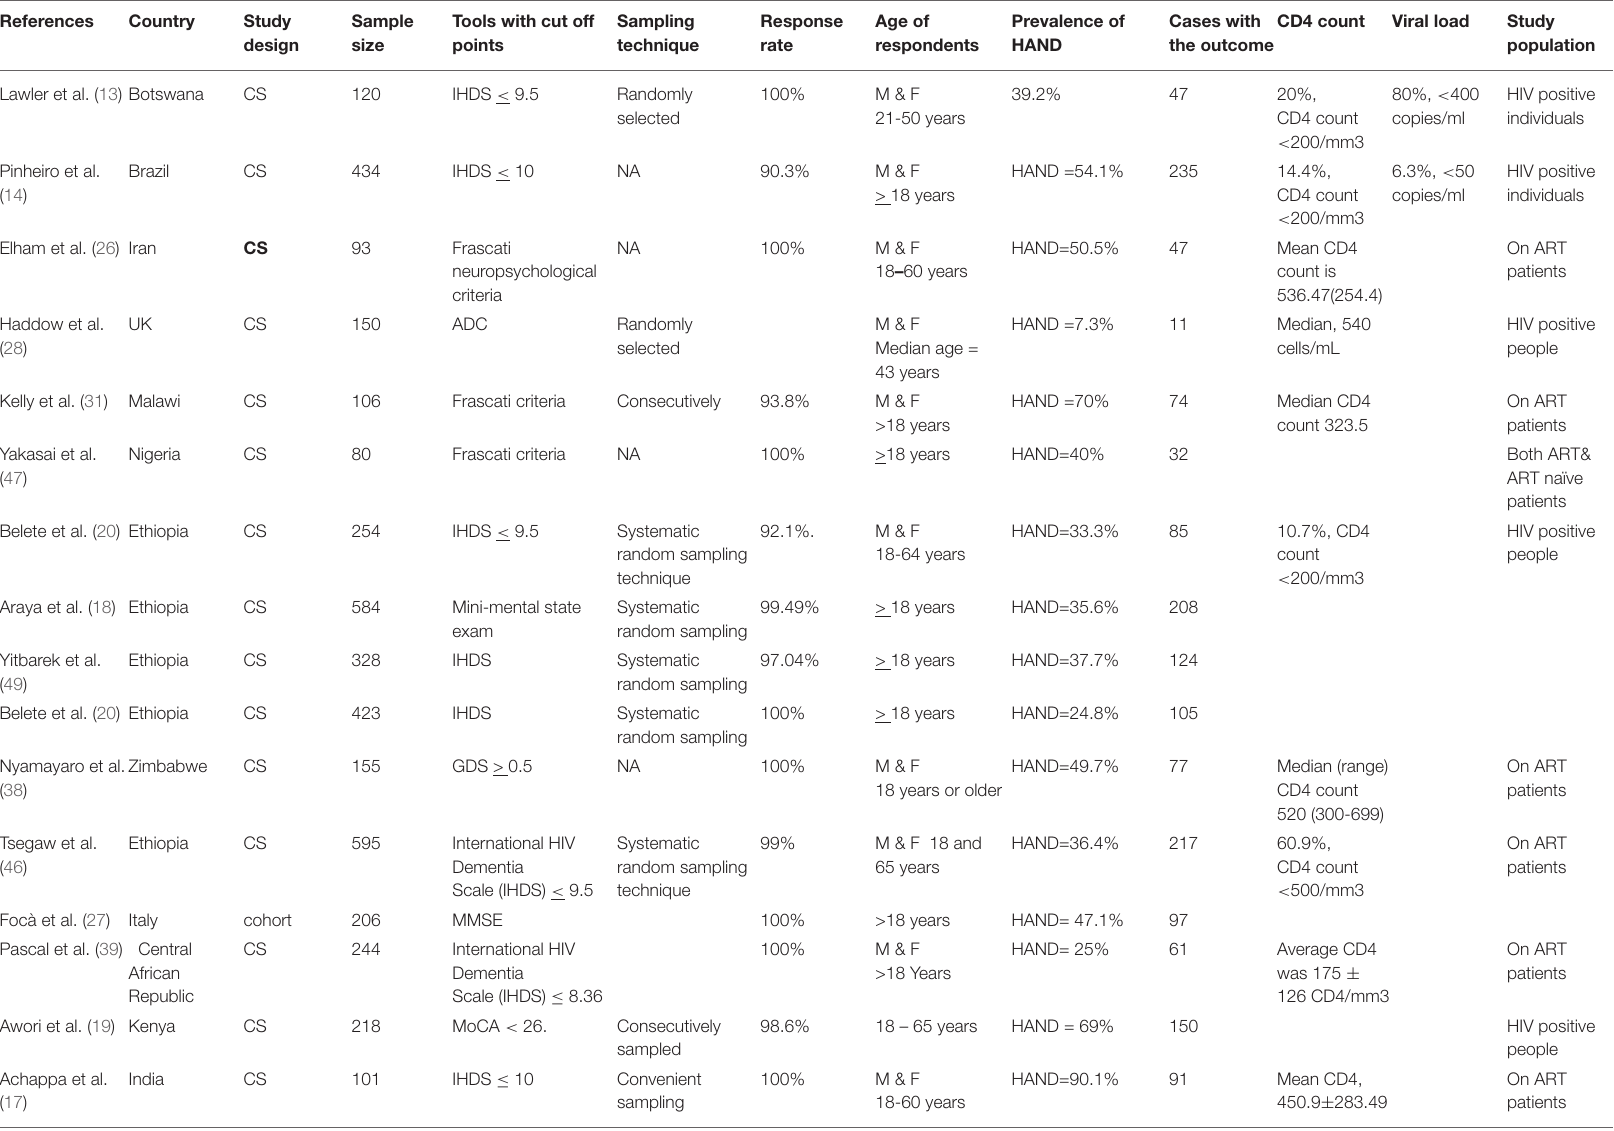
TABLE 1 | Characteristics of studies on HIV associated neurocognitive disorders in HIV/AIDS patients which are incorporated in this